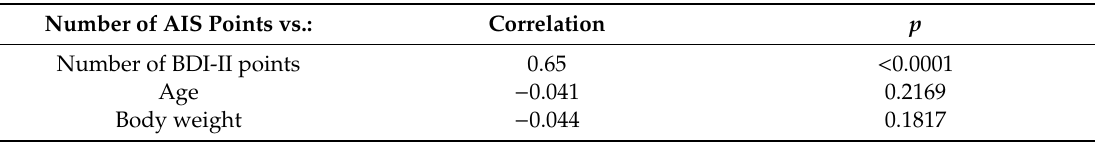
Table 6. Correlation between Beck Depression Inventory questionnaire (BDI-II) and AIS scores and Table 5. Correlation between BDI-II and AIS scores and body weight and age of the respondents by body weight and age of the respondents by means of Spearman’s rank means of Spearman’s rank method.